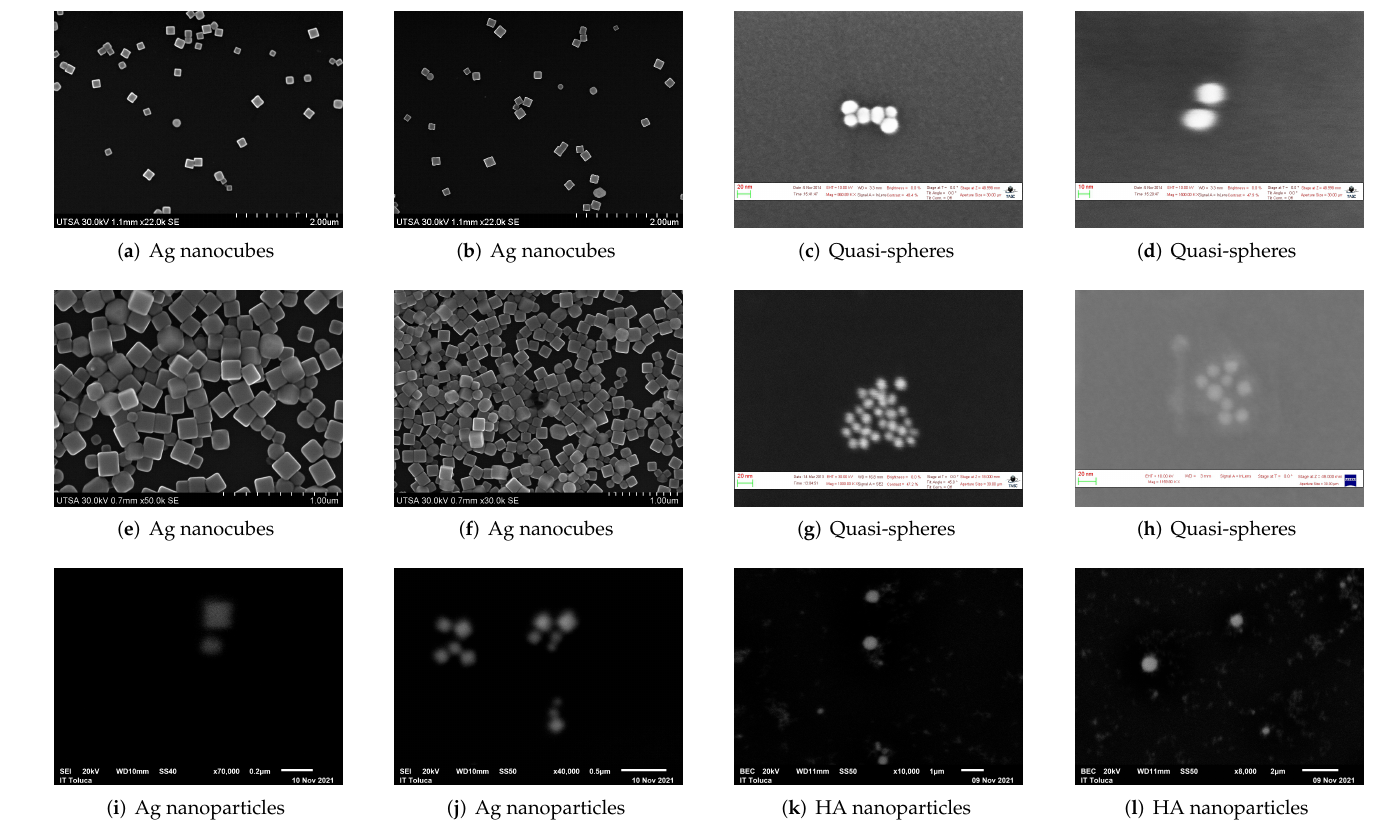
Figure 7. Some images from the three datasets used for the evaluation of the trained models. Dataset I (first row); Dataset II (second row); Dataset III (third